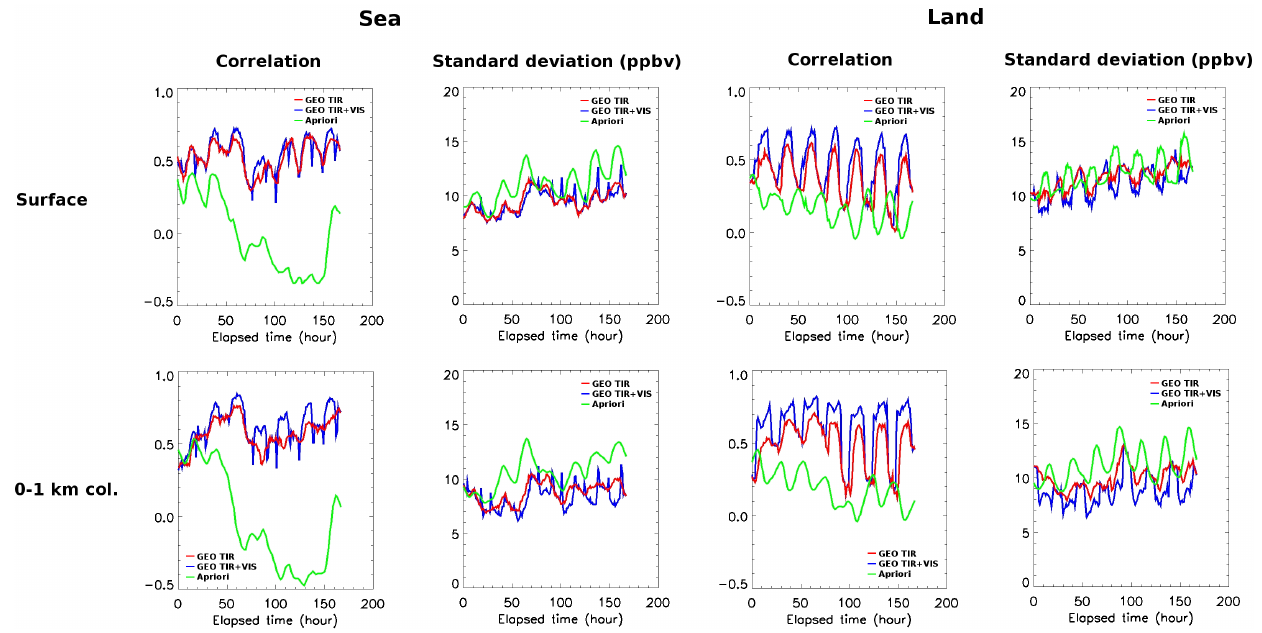
Figure 10. As in Fig. 8 but for the sea pixels (first and second column) and land pixels (third and fourth column). First and third columns show the correlation; second and fourth columns show the standard deviation.